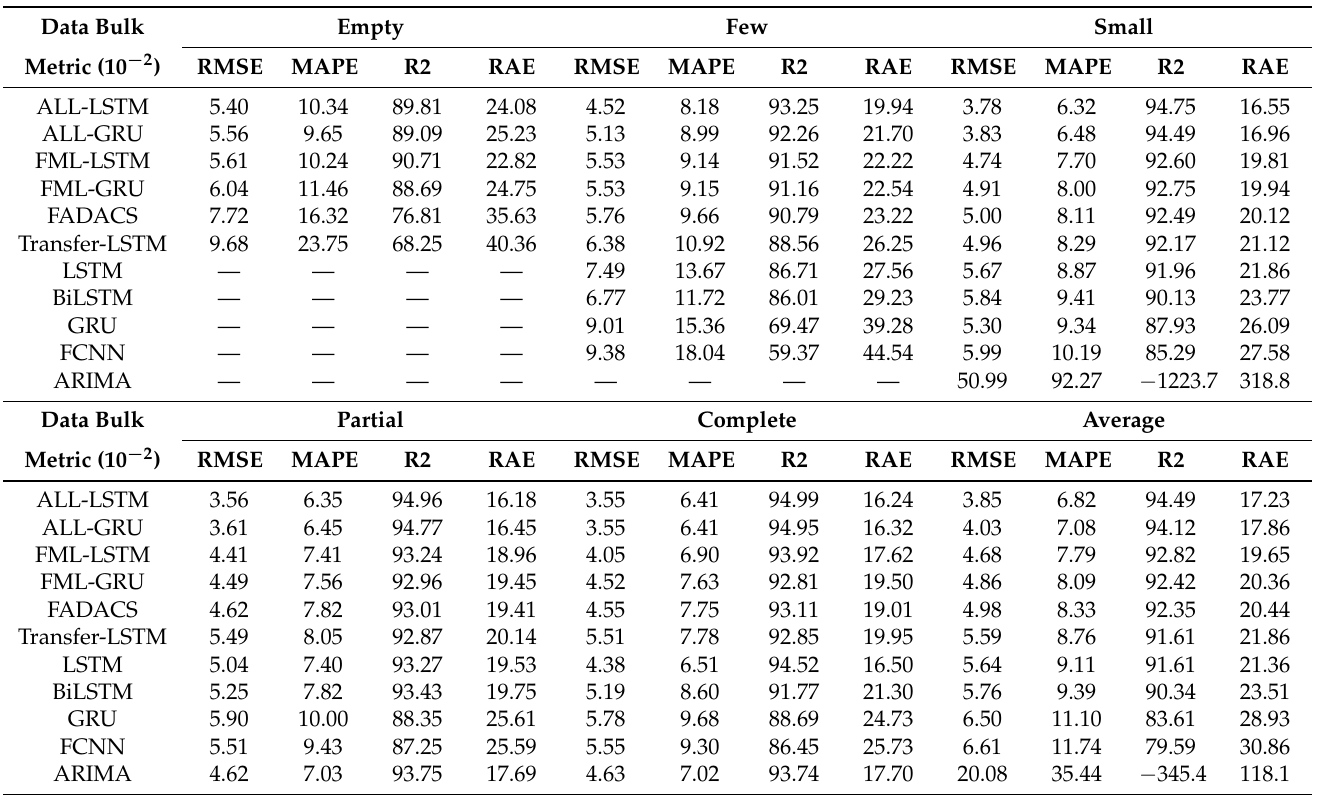
Table 5. The list of evaluation metrics of compared models in different data